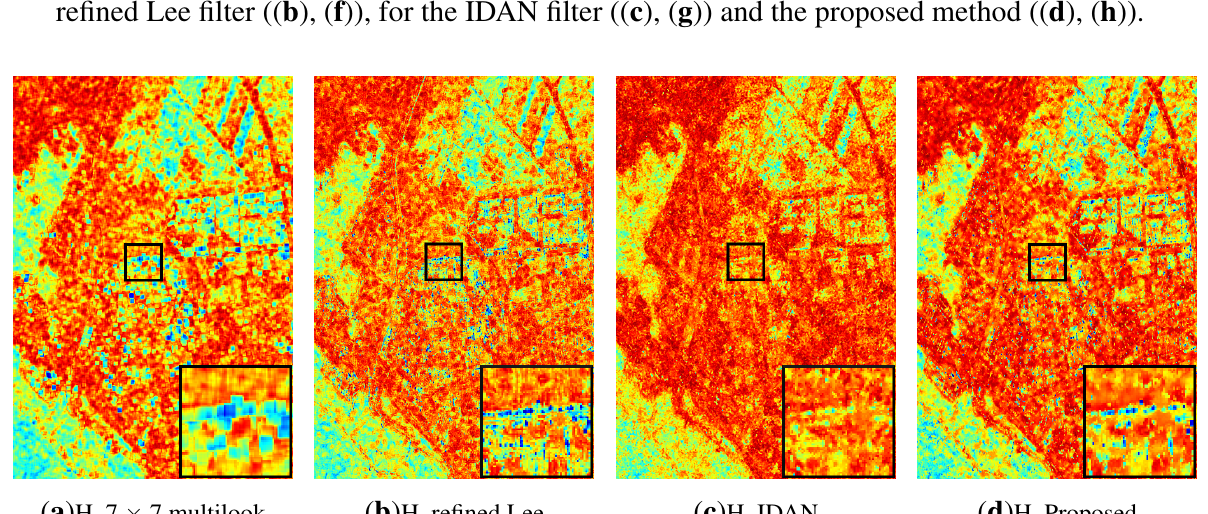
Figure 7. Entropy (H) and averaged alpha angle ( ¯ α ) for 7 × 7 multilook (( a ), ( e )), for the refined Lee filter (( b ), ( f )), for the IDAN filter (( c ), ( g )) and the proposed method (( d ), ( h